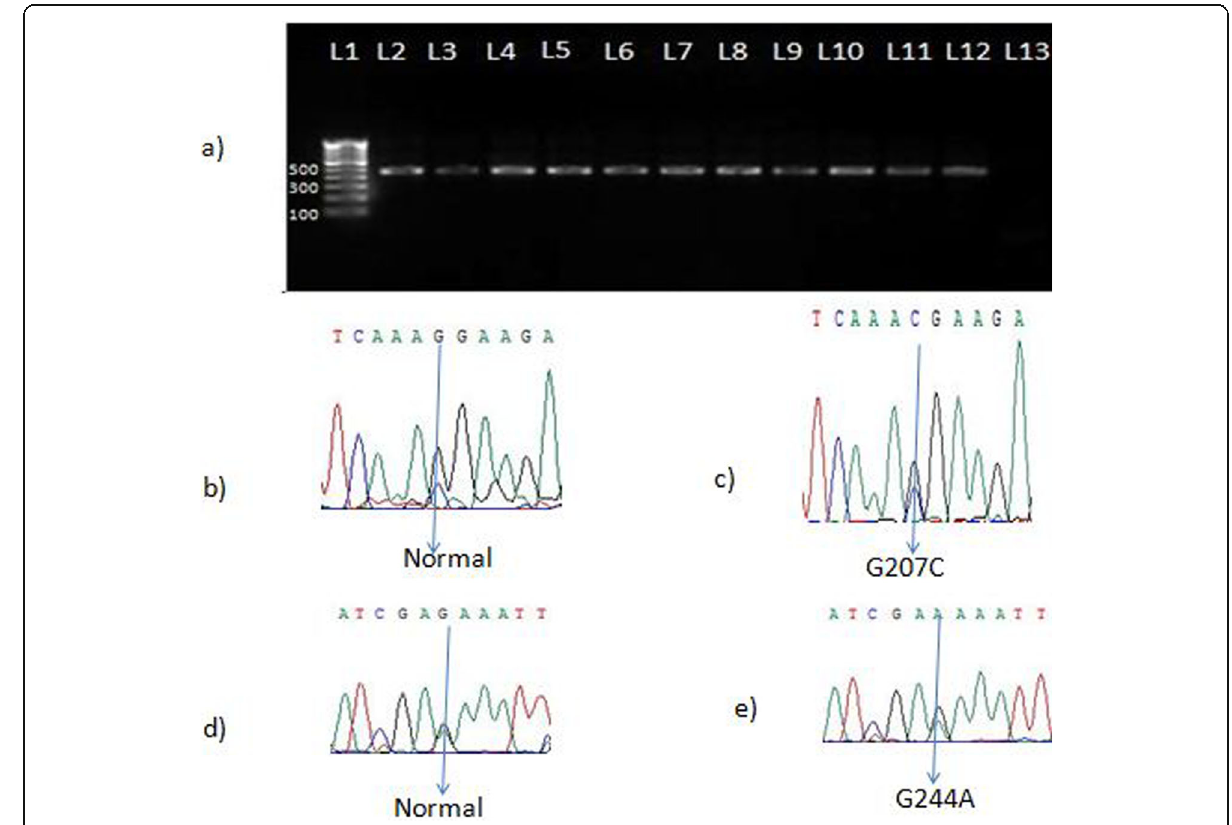
Fig. 5 a Image of PCR product of 467 bp image of NCOR1 gene on 1.5% gel electrophoresis containing ethidium bromide. L1 = 100 bp ladder, L2 – L12 = cases, and L13 = negative control. b Normal case. c Variant G207C in cases. d Normal case. e Variant G244A in